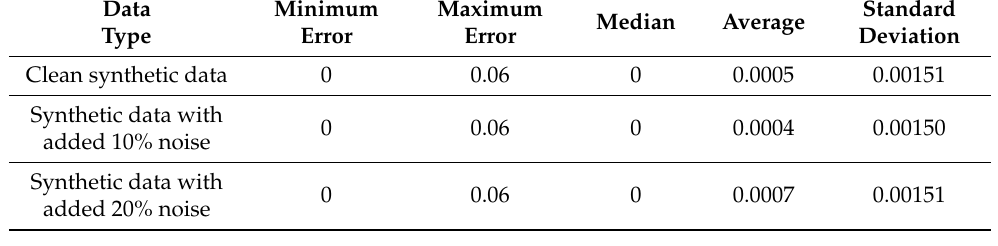
Table 1. Basic statistical parameters of the absolute error values (in seconds) for the synthetic dataset.